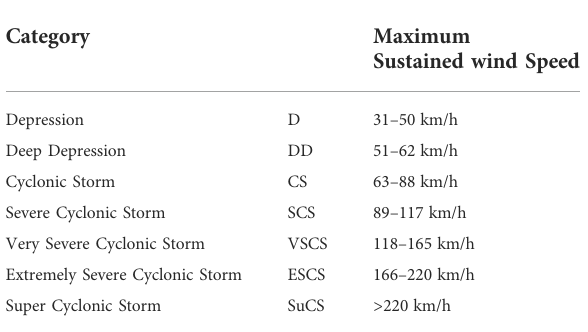
FIGURE 1 Annual cycle of NIO TCs frequency from 1891 to 2020 using IMD